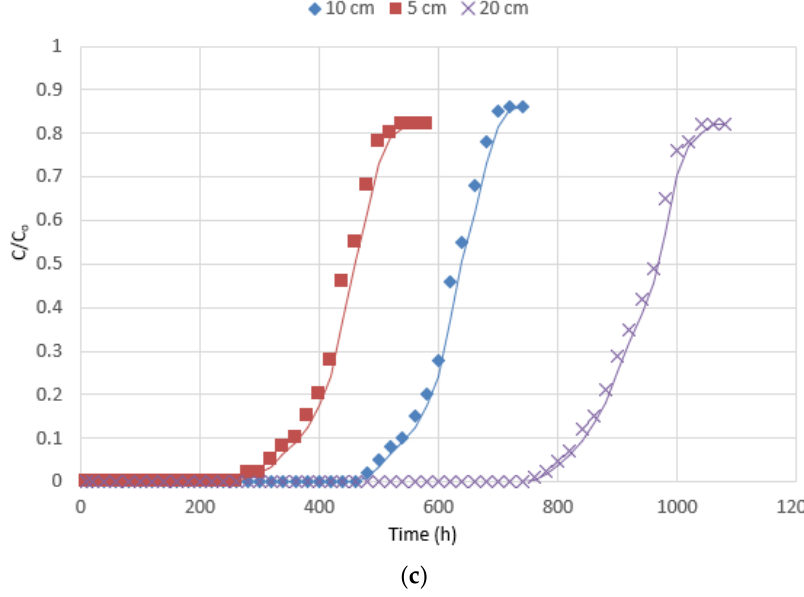
Figure 4. ( a ) Breakthrough curve for the adsorption of EE2 by PMPS at varying flow rates (Z = 10 cm, C o = 2 mg/L); ( b ) Breakthrough curve for the adsorption of EE2 by PMPS at varying influent concentrations (Z = 10 cm, flowrate = 5.5 mL/min); ( c ) Breakthrough curve for the adsorption of EE2 by PMPS at varying bed heights (C o = 2 mg/L, flowrate = 5.5 mL/min).